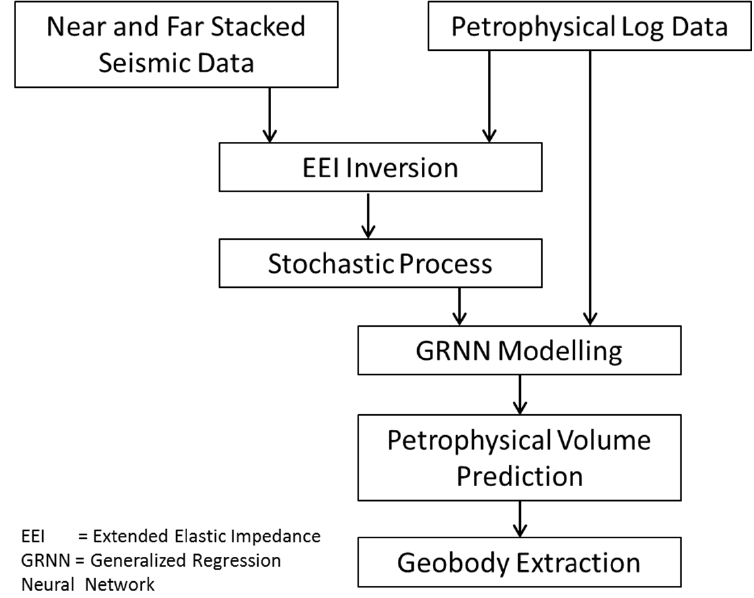
Figure 5. Work fl ow of inversion. Figure 5. Workflow of